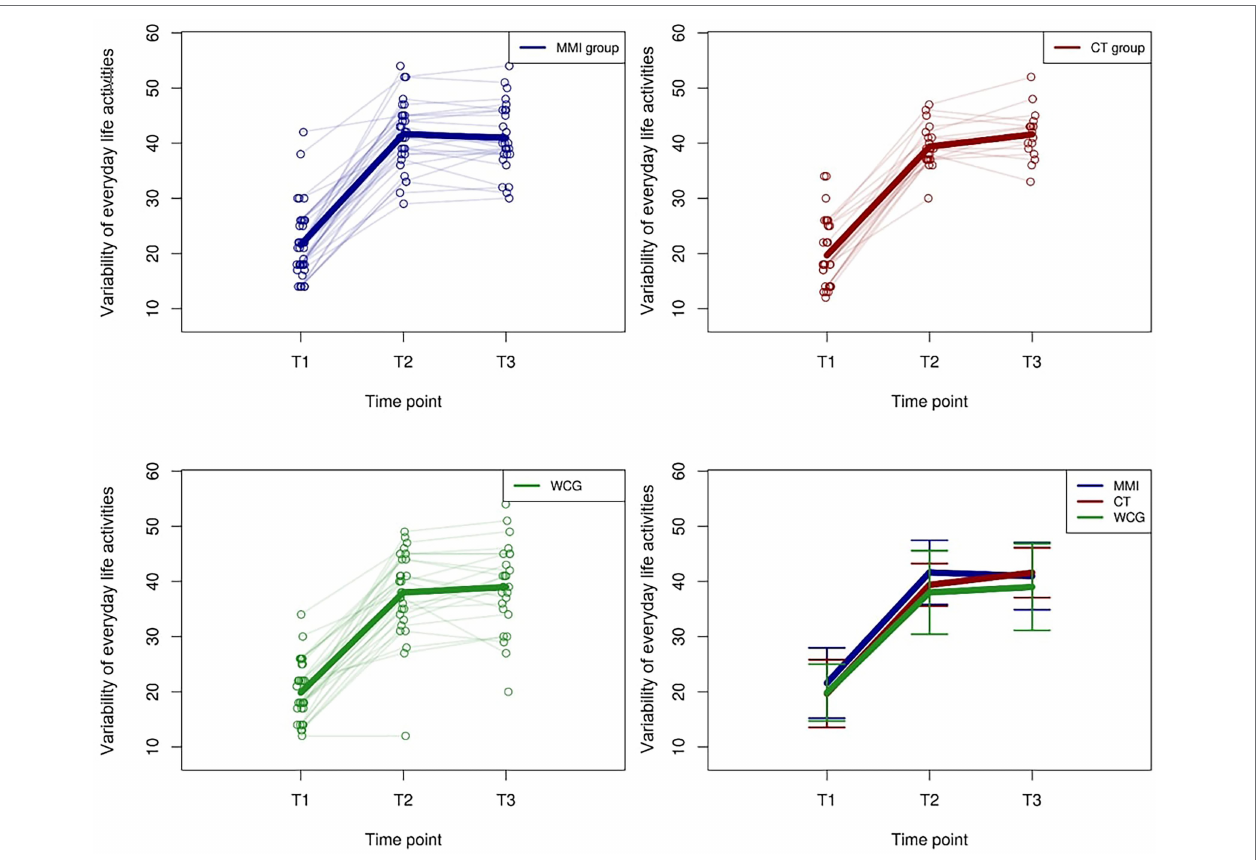
FIGURE 5 | Trajectories of “Variability of everyday life activities” values for the MMI group, the CT group, and the WCG. The thick lines indicate the mean